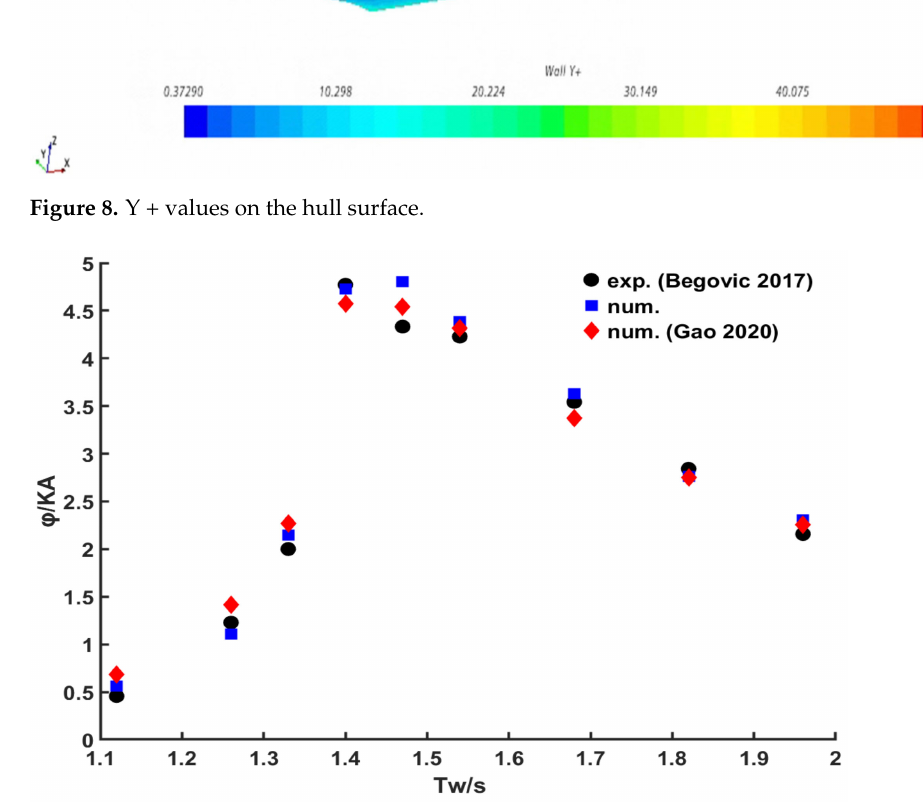
Figure 9. Comparison of the pure refined CFD and reference results